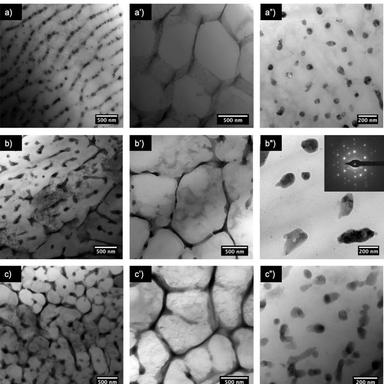
TEM micrographs of Al-Zn-Mg at several magnifications - (a, a' and a") Al-10Zn-2Mg; (b, b' and b") Al-14Zn-3Mg; (c, c' and c") Al\\18Zn\\4Mg. The low magnification of the alloys (a, b and c) show coarse cellular dendrites of the melt pool and (a', b', and c') shows the cell-like structures at the heat affected zone. High magnification (a", b" and c") images reveal second phase particles with different contrast with the size range of 50 to 200 nm.